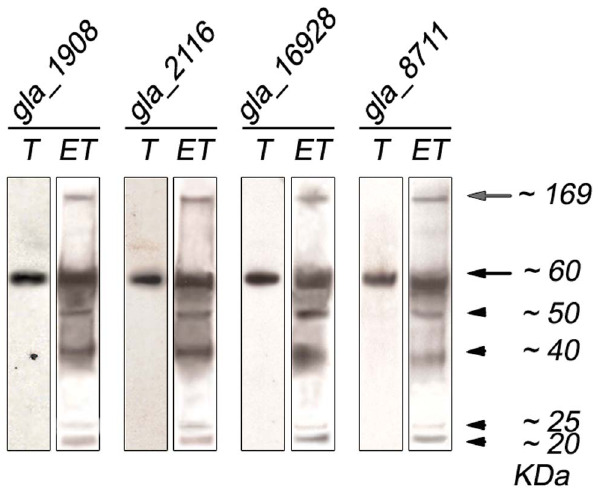
Figure 10. Analysis of palmitoylated proteins in dhhc trans- genic growing and encysting parasites displays a similar pattern to wild type parasites. Giardia trophozoites (T) or encysting trophozoites (ET) were labeled with [ 3 H]-palmitic acid and loaded onto SDS-PAGE. Samples were then analyzed by autoradiography. The approximate sizes are indicated on the right in kDa.